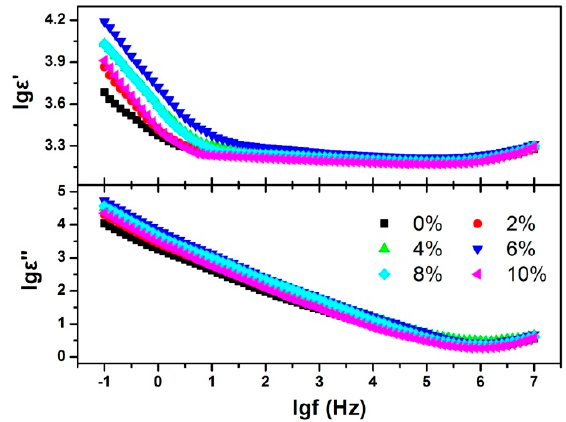
Figure 6. The variations of ε′ and ε″ with frequency of SrF 2 :Tb 3+ nanocrystals.